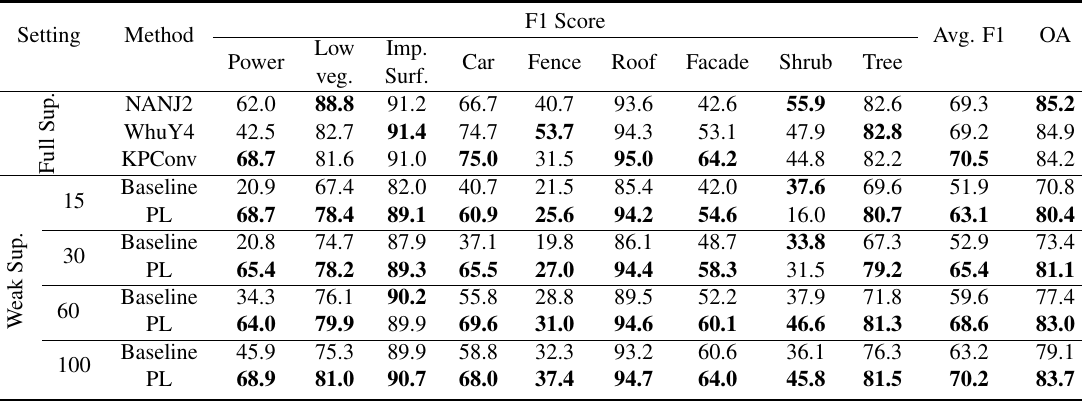
Table 2. Comparison of full supervision and weak